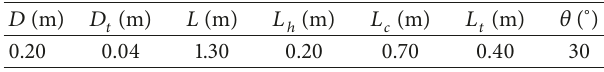
Table 1: Dimensional parameters of the